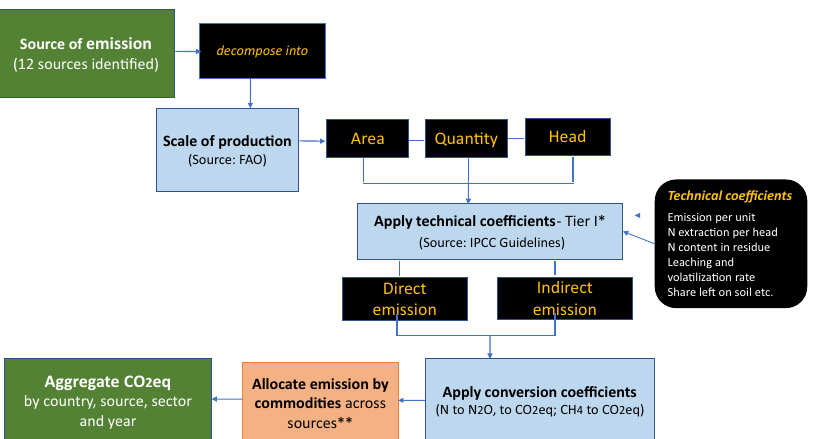
Fig. 4 Creation of database of GHG emission from agriculture. The fi gure shows the various steps in creating the database of GHG emissions from agriculture by source, location, commodity, production stage, and technology. Tier I (*) refers to default emission factors as de fi ned in the 2006 guidelines of the Inter-governmental Panel for Climate Change (IPCC)[17]. The step allocating emissions by commodities and by source of emissions (**) involved using a matrix of disaggregated space and linkage. Source: authors ’ depiction.